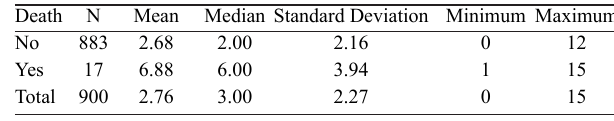
Table 4. Comparison of EuroSCORE according to DDRF.